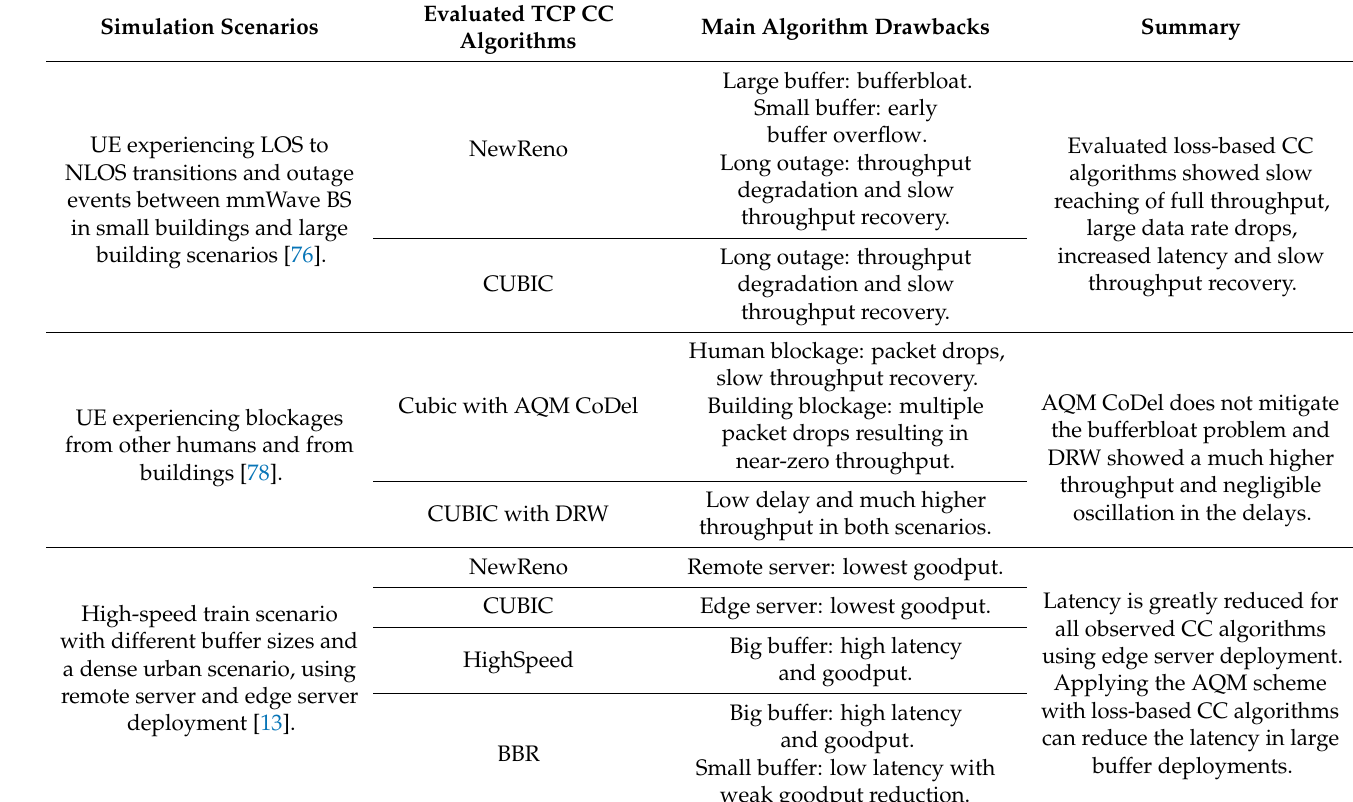
Table 2. Review of the research articles on CC algorithms in 5G